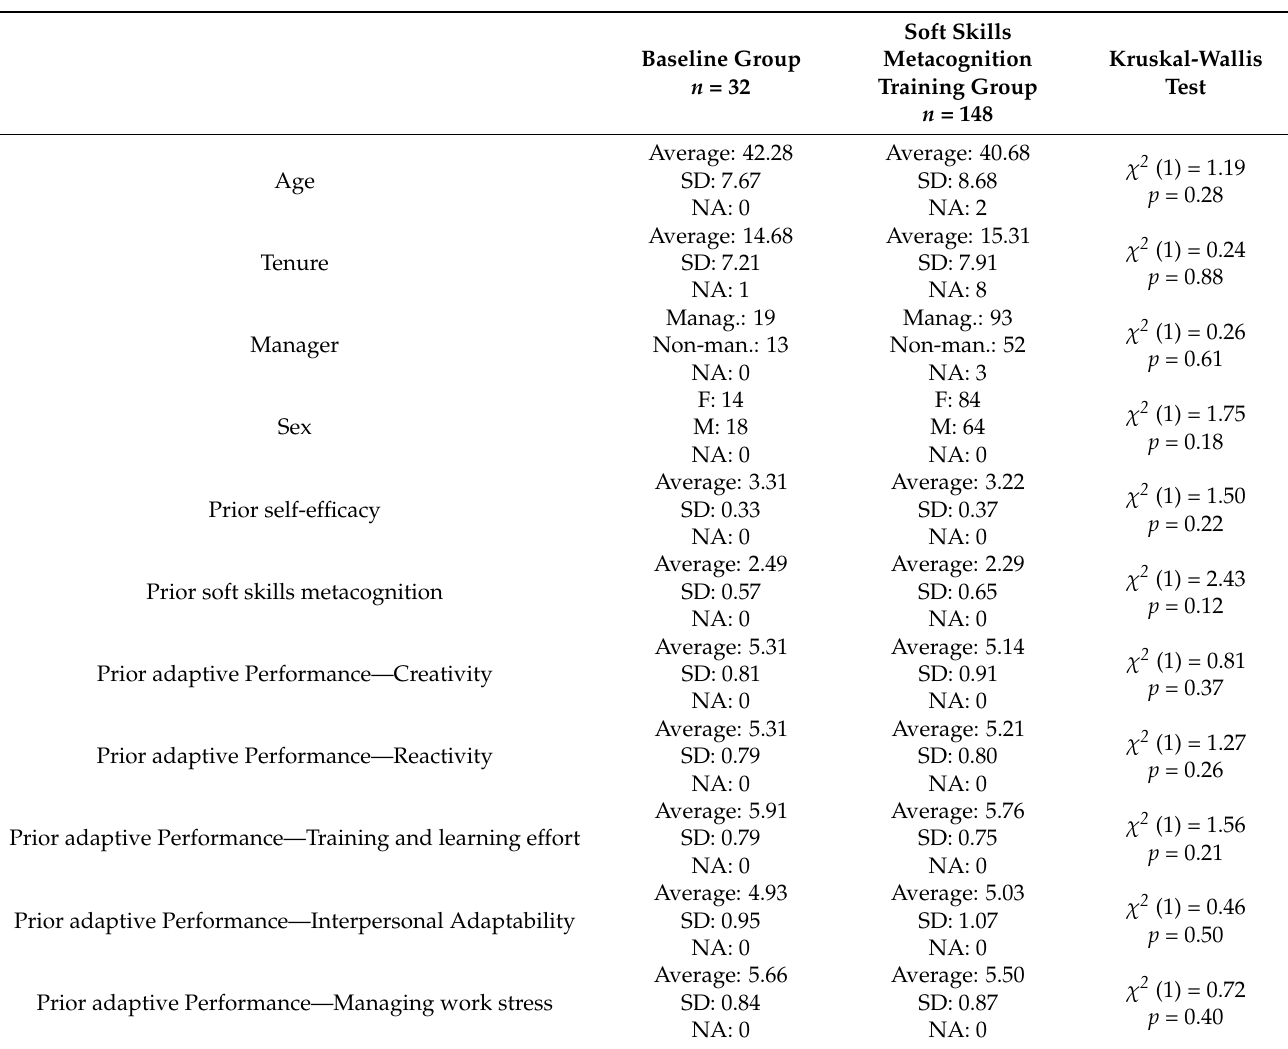
Table 1. Between-groups comparison for demographic variables and prior levels of soft skills metacognition, self-efficacy and adaptive performance.